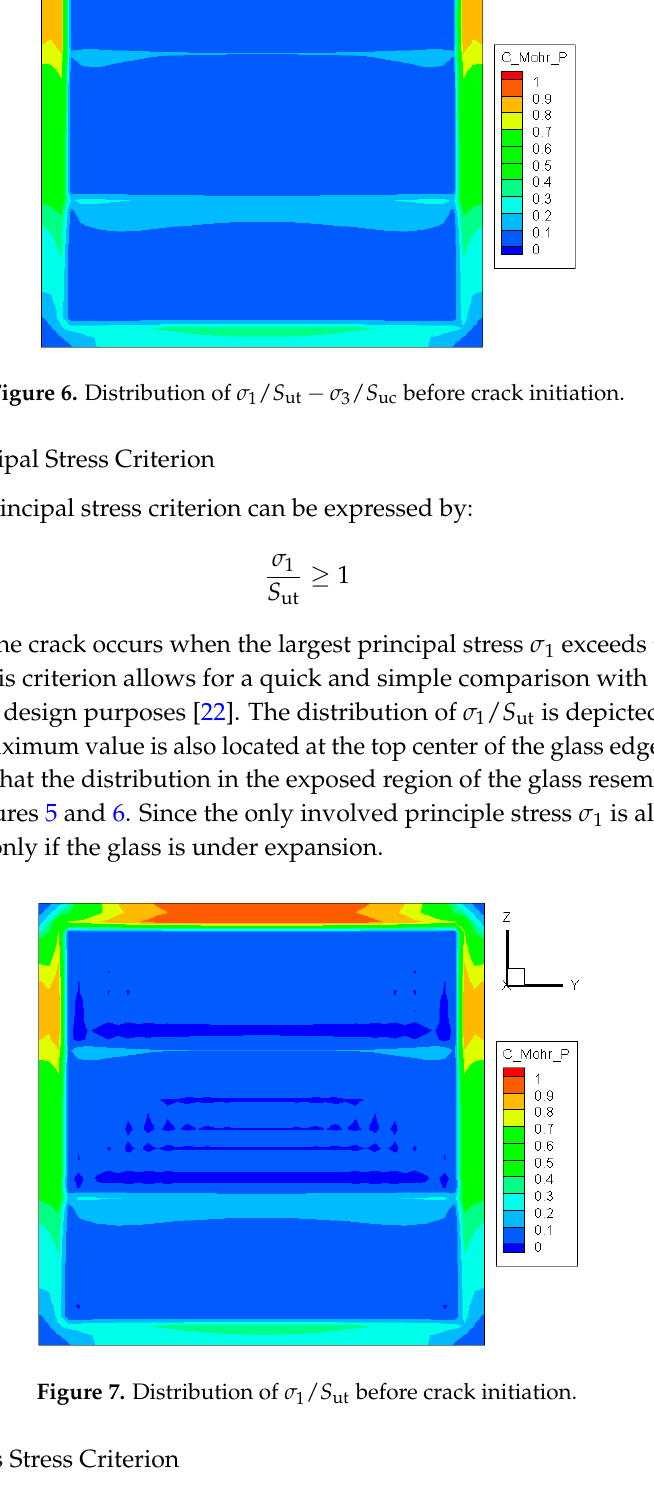
Figure 7. Distribution of σ / S before crack initiation.